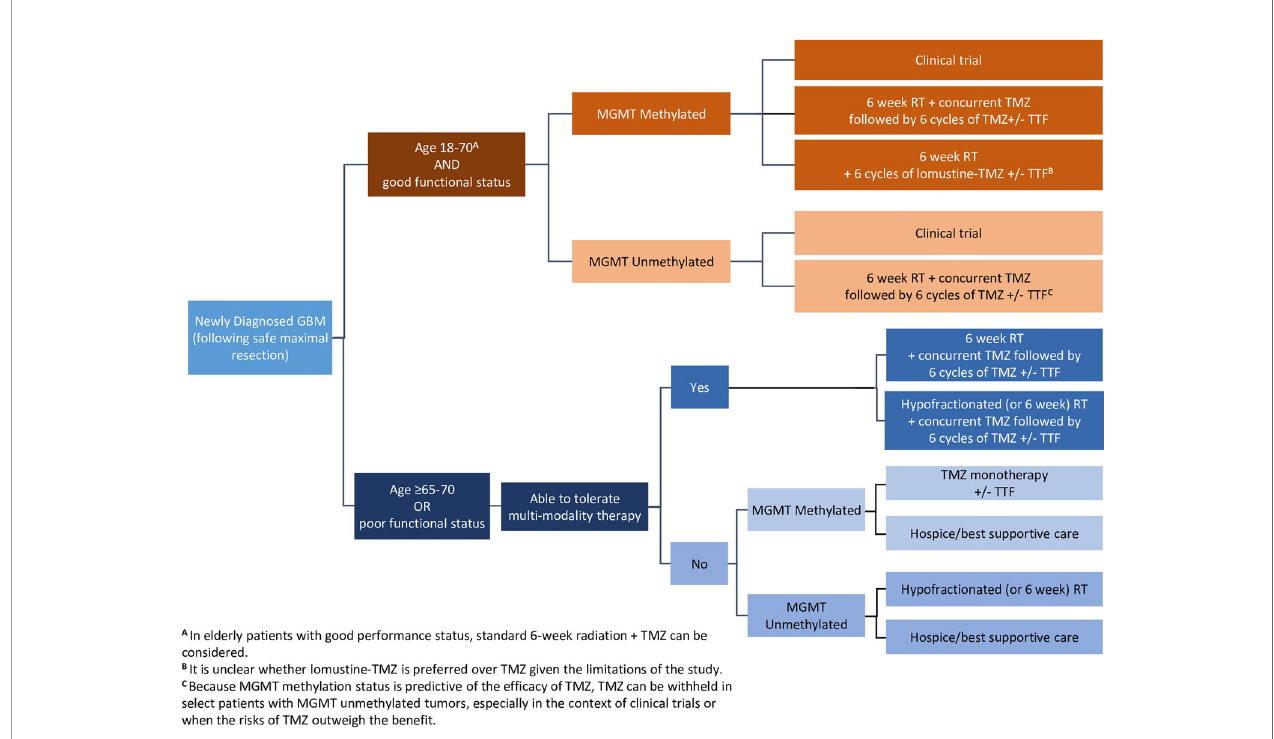
FIGURE 1 | Wen, et al. Adult glioblastoma management: a Society for Neuro-Oncology (SNO) and European Society of Neuro-Oncology (EANO) consensus review. Neuro-Oncology. 2020;22(8):1073 – 1113. DOI: 10.1093/neuonc/noaa106 . Adapted and r eprinted by permission of Oxford University Press on behalf of the Society for Neuro-Oncology. GBM, glioblastoma; MGMT, O(6)-methylguanine-DNA methyltransferase; RT, radiation therapy; TMZ, temozolomide; TTF, Tumor Treating Fields. Disclaimer: OUP and SNO are not responsible or in any way liable for the accuracy of the adaptation. Licensee is solely responsible for the adaptation in this